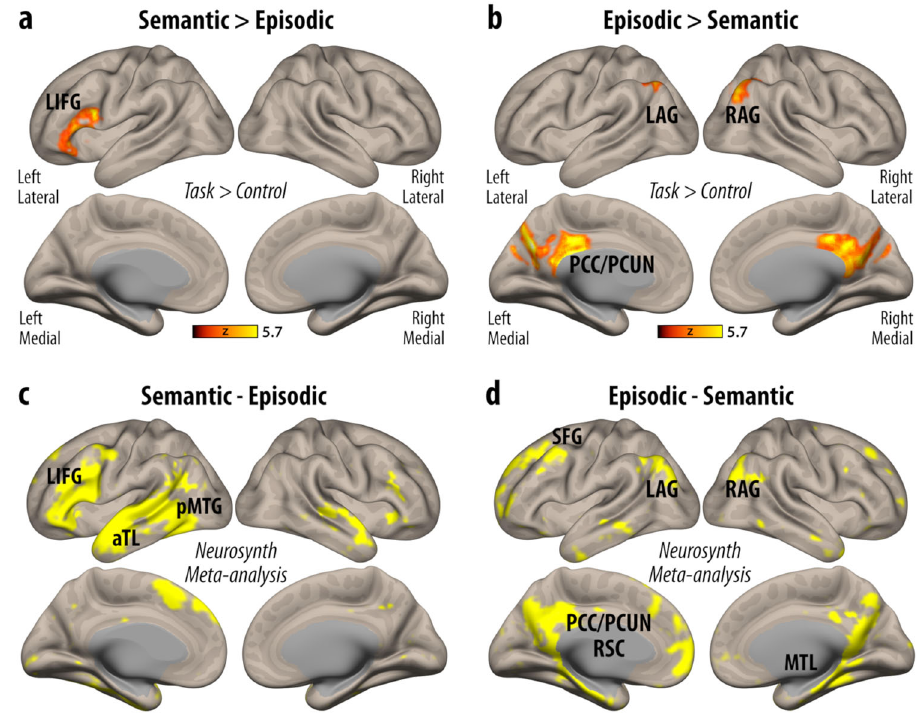
Fig. 2 Differential brain activity patterns in the retrieval of long-term memory types. a The comparison of semantic to episodic memory retrieval, across all trial types versus control trials, revealed greater activity in the left inferior frontal gyrus (LIFG). b The reverse contrast on the other hand, illustrated greater activity centred on the posterior cingulate/precuneal cortices (PCC/PCUN) and bilateral angular gyri (AG) extending towards the lateral occipital cortex. c , d These results spatially overlapped with meta-analytic difference maps obtained from the subtraction of association maps linked to the cognitive terms semantic ( n = 1031) versus episodic ( n = 488) in the Neurosynth database 57 (aTL = anterior temporal lobe, pMTG = posterior middle temporal gyrus, SFG = superior frontal gyrus, RSC = retrosplenial cortex, MTL = medial temporal lobe). All task-fMRI results were corrected for general task dif fi culty effects using inverse ef fi ciency scores across memory tasks as covariates of no